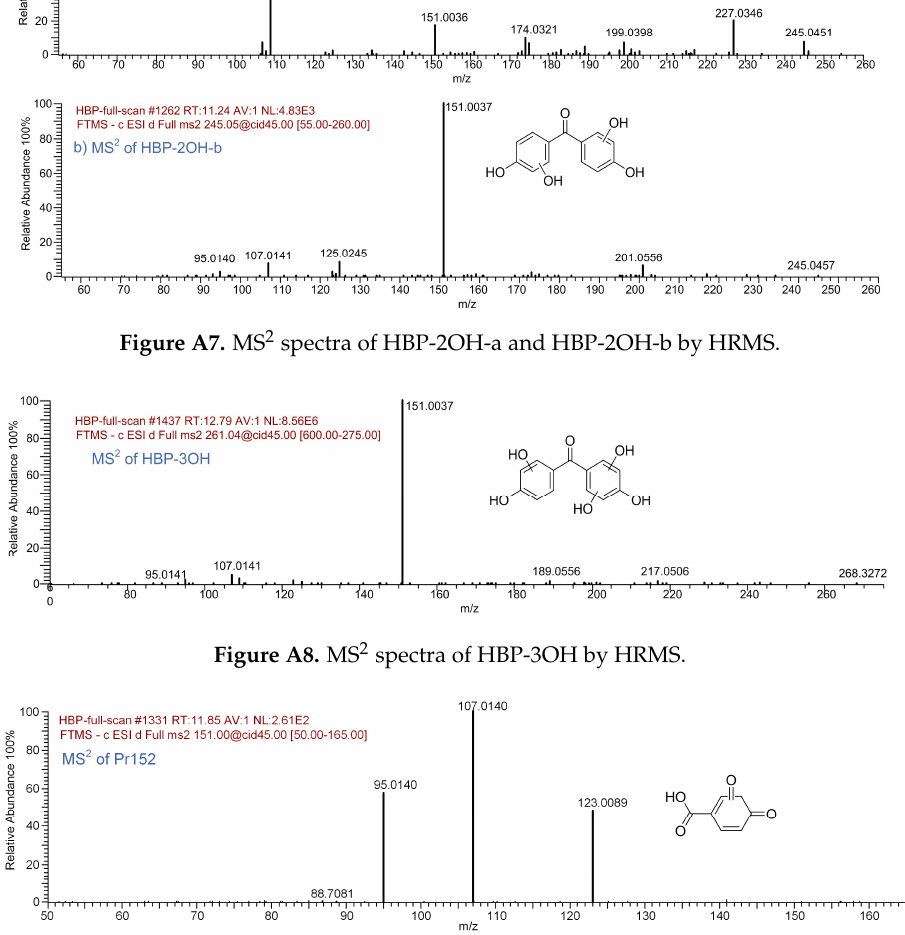
Figure A9. MS 2 spectra of Pr152 by HRMS.